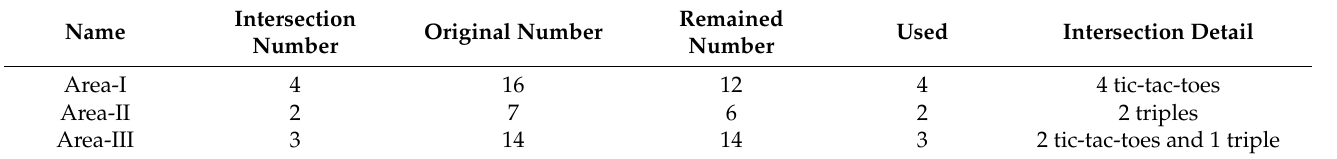
Table 2. The intersection POIs in three areas and their attributes.